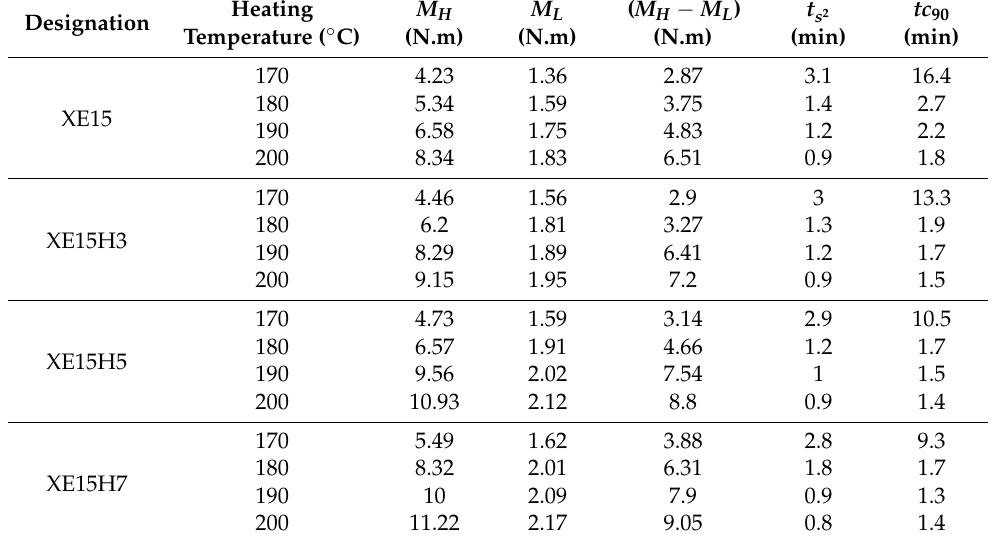
Table 2. Cure parameters of XNBR/epoxy/XHNT nanocomposites at various heating rates.